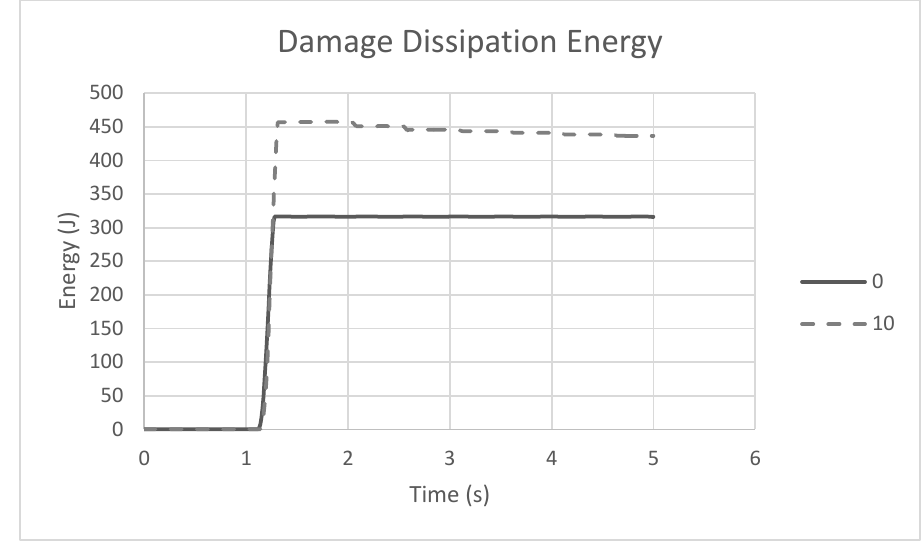
Fig. 14. Damage energy